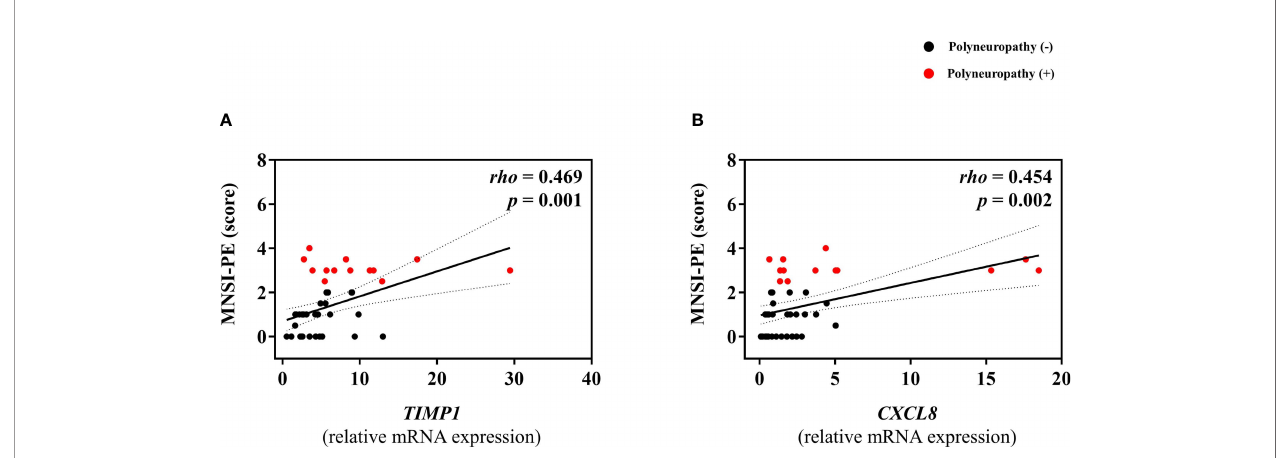
FIGURE 3 | Correlations between mRNA expression level of TIMP1 (A) or CXCL8 (B) , and MNSI-PE scores in subjects with